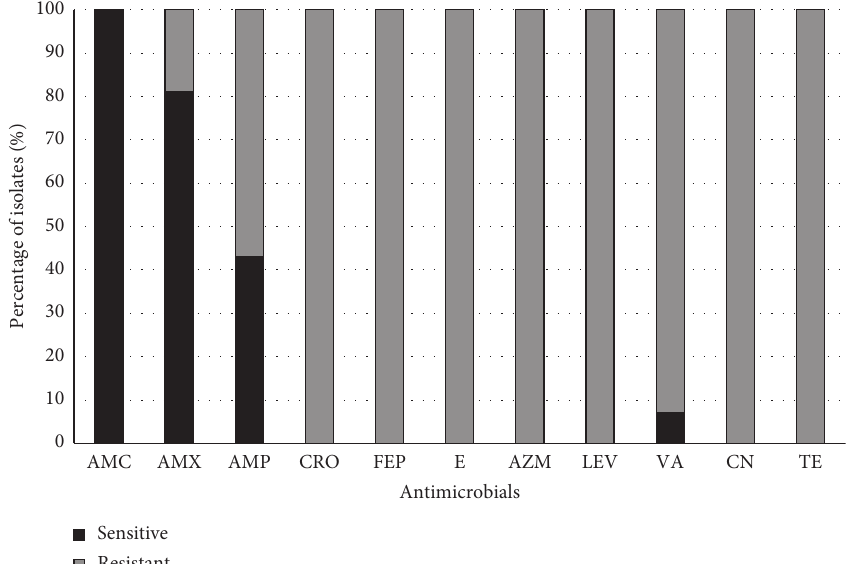
Figure 2: Antimicrobial sensitivity results of S. pyogenes isolates. AMC : amoxicillin/clavulanic acid, AMX: amoxicillin, AMP: ampicillin, CRO :ceftriaxone, FEP :cefepime, E :erythromycin, AZM: azithromycin, LEV :levofloxacin, VA :vancomycin, CN:gentamicin, TE: